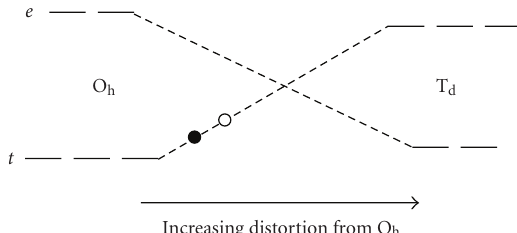
Figure 5: Schematic representation of the interchange between the t- and e-states arising from the five nd atomic orbitals is the local environment and is distorted from octahedral to tetrahedral. Sites with di ff erent degrees of distortion will give rise to bands at di ff erent energies as shown by the filled and open